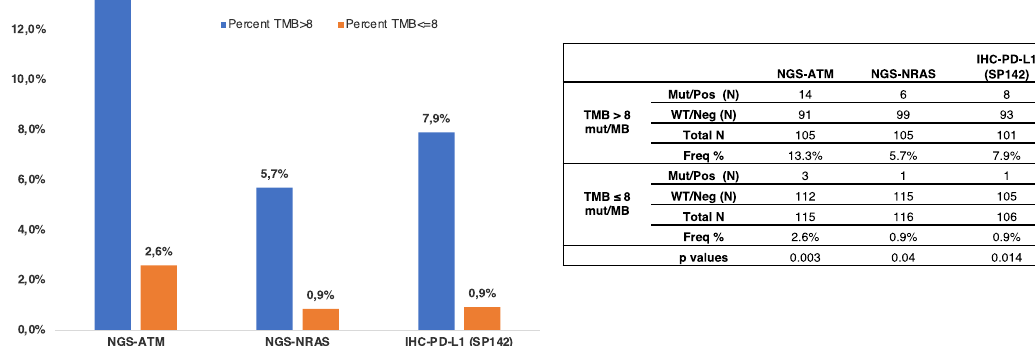
Fig. 5 Molecular alterations associated with high tumor mutational burden (TMB) in microsatellite stable (MSS) lymph nodes metastases. MSS lymph nodes carrying TMB higher than median (i.e., 8 mut/MB) were compared to those that are lower, statistically signi fi cant results are